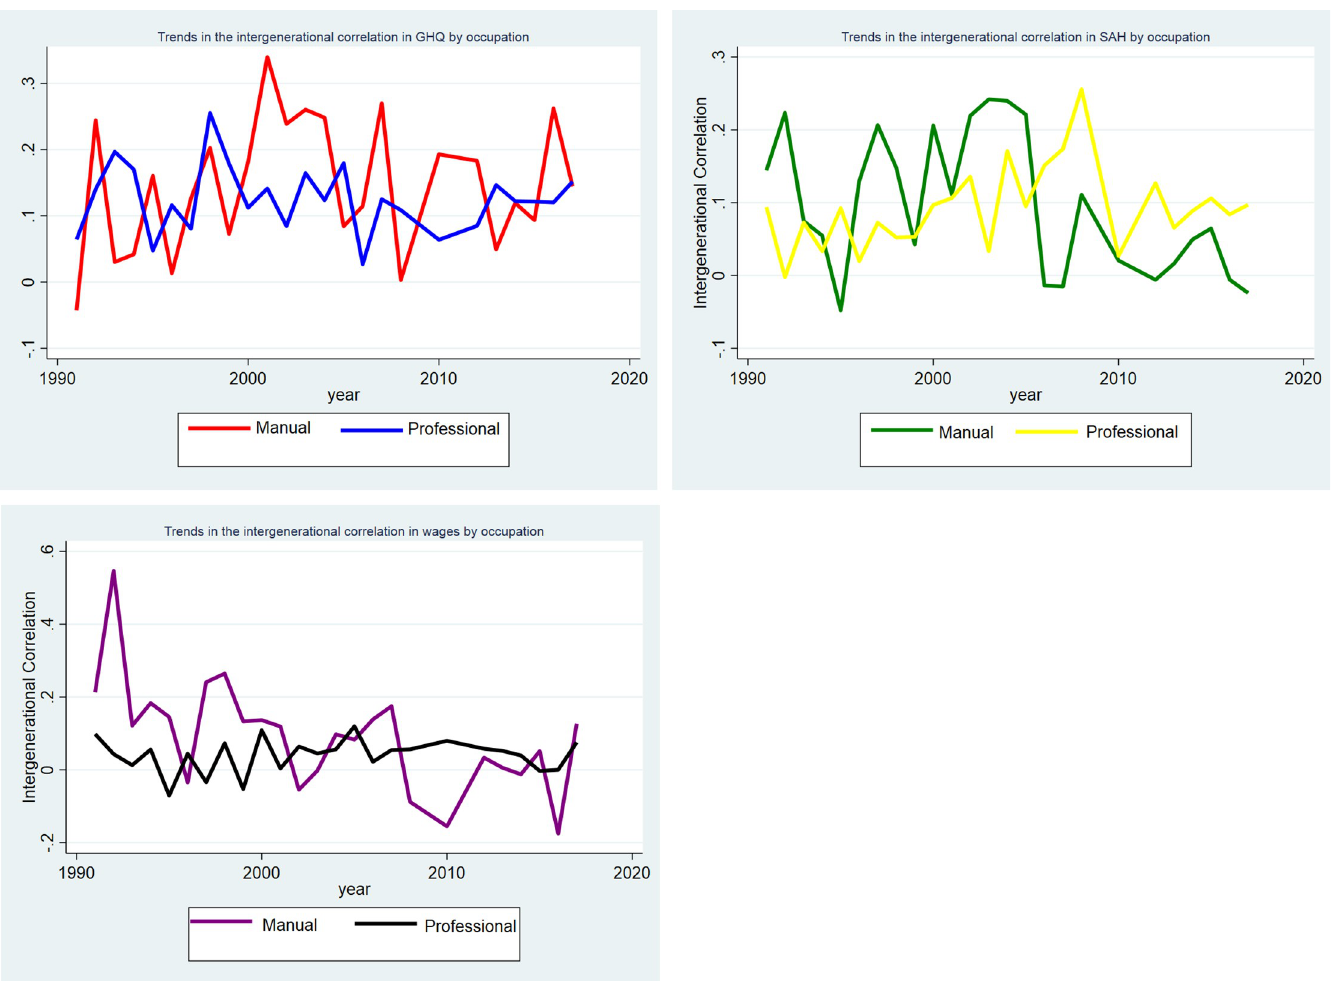
Fig 4. A: Trends in the intergenerational correlation in GHQ between 1991–2017 by parental occupation. B: Trends in the intergenerational correlation in SAH between 1991–2017 by parental occupation. C: Trends in the intergenerational correlation in log of hourly wages between 1991–2017 by parental occupation.